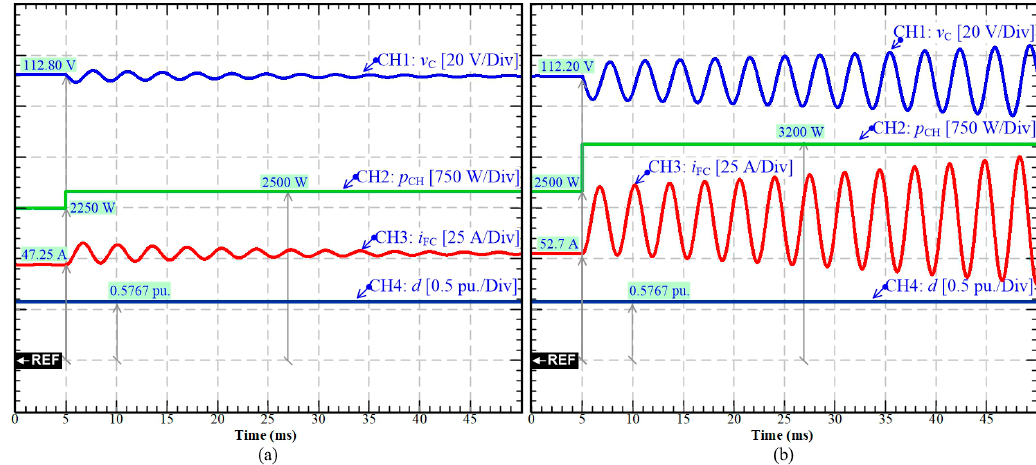
Figure 6. Simulation results: CPL step of the 2-phase FC boost converter with the open-loop control at a constant duty cycle d = 0.5767: ( a ) from 2250 W to 2500 W; ( b ) from 2500 W to 3200 W.